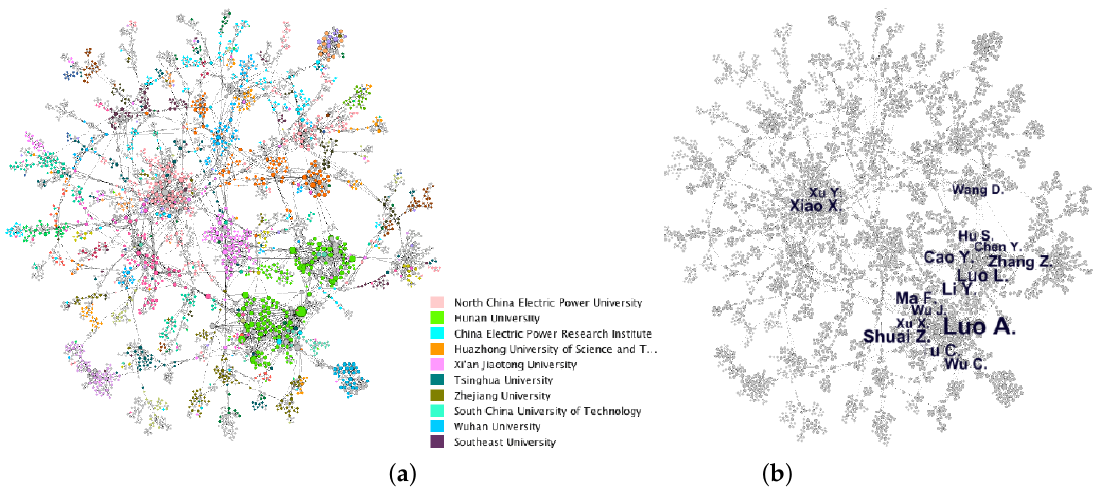
Figure 8. ( a ) collaborations among Chinese researchers working in power quality; ( b ) researchers with eigenvector centrality value above 0.30.